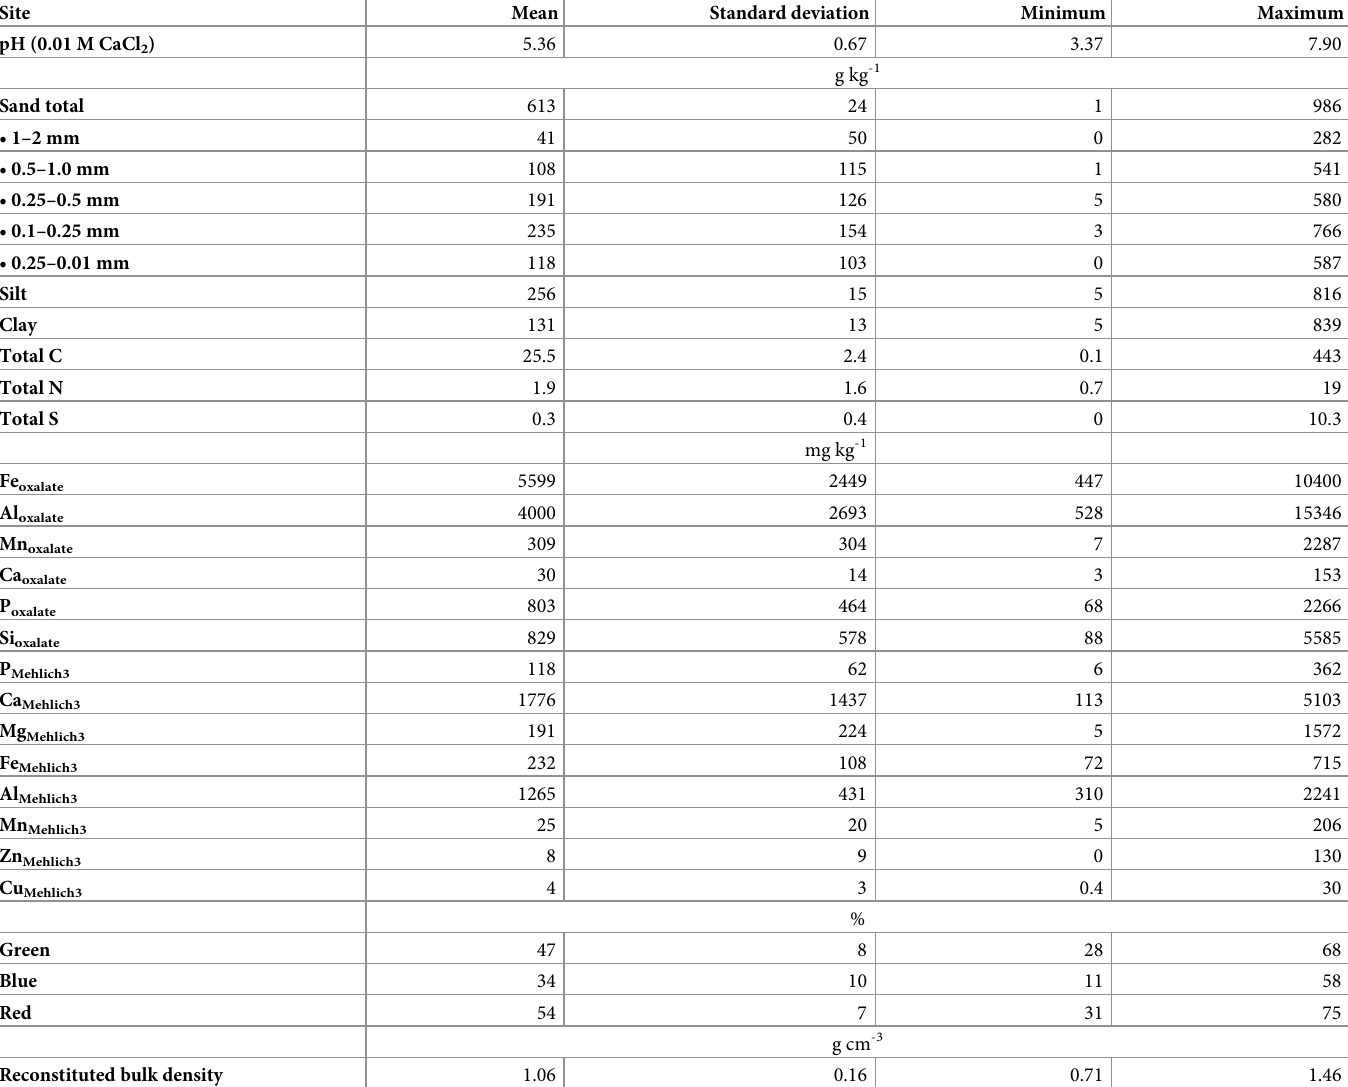
Table 1. Ranges of soil properties (0–20 cm) in the data set (particle-size distribution according to the multi-point 7-h sedimentation method using 45-sec settling time for sand and 7-h settling time for